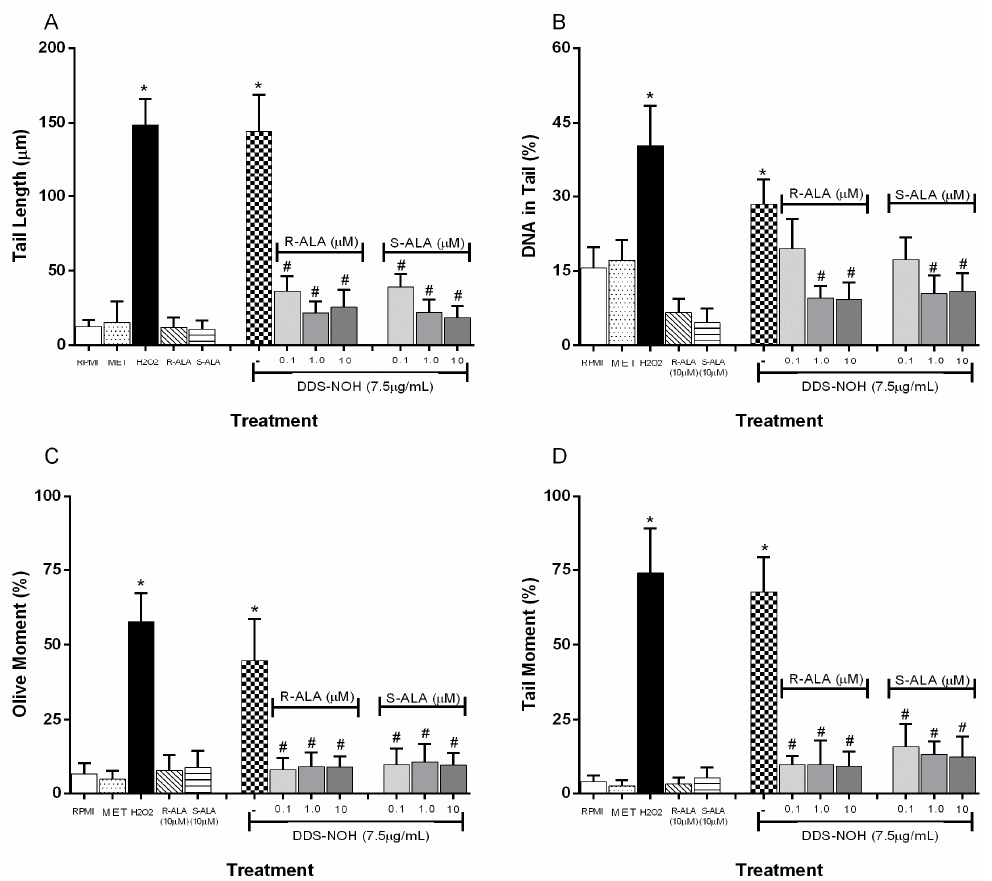
Figure 7. Effect of pretreatment with R-ALA or S-ALA on DNA damage induced by DDS-NHOH. Tail length ( µ m— A ), DNA in tail (%— B ) tail moment (TM— C ) and Olive moment (OM— D ) were used as a marker of DNA damage in lymphocytes using comet assay. All values are depicted as mean ± SE. Values are means ± S.E.M. * p < 0.05 compared to methanol. # p < 0.05 compared to the DDS-NOH group.